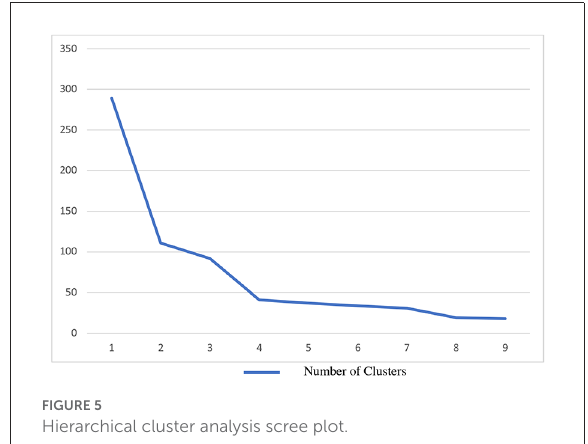
FIGURE5 Hierarchical cluster analysis scree